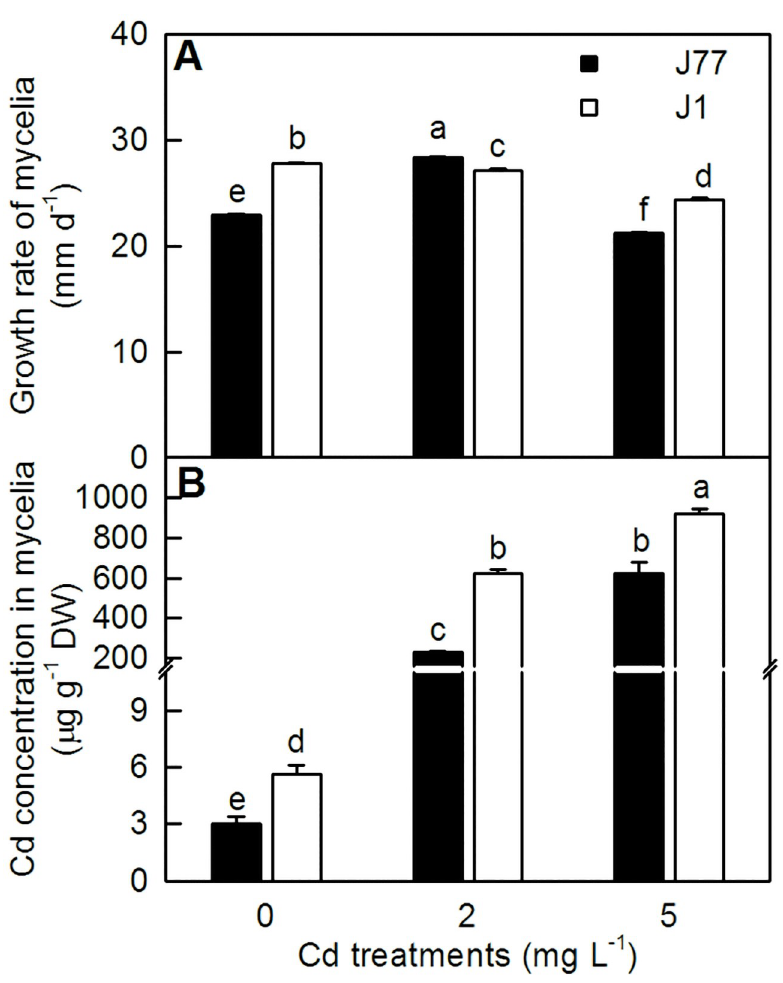
Fig 1. Growth rate of mycelia (a) and Cd concentration in mycelia (b) in response to Cd. Bars represent means ± SD ( n = 3); Different letters above the bars indicate a significant difference at P <